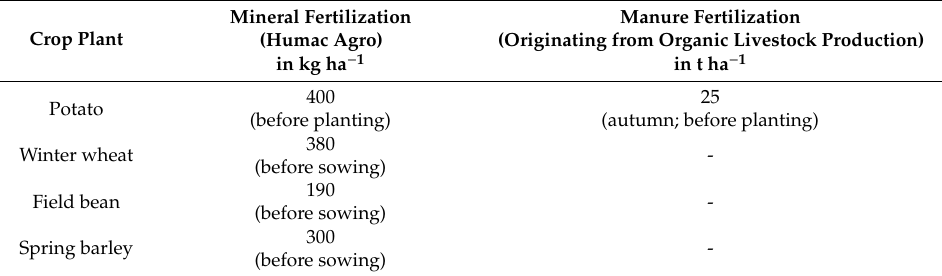
Table 4. Fertilization applied in the organic system.